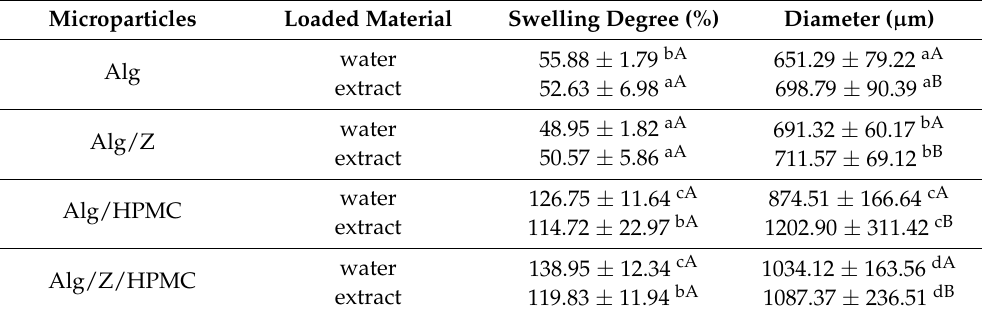
Table 3. Physical properties of microparticles with different coating materials loaded with rosemary extract and distilled water as loading materials (swelling degree and diameter of